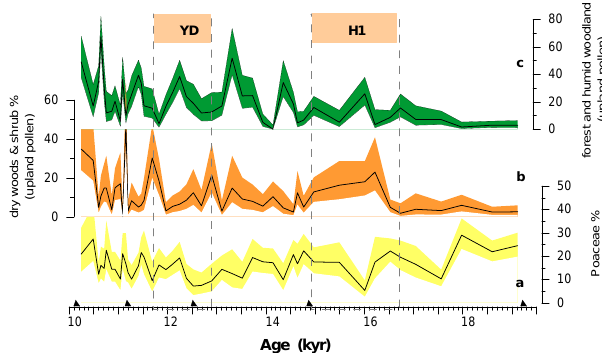
Figure 8. Palynological data showing relative abundances of (a) grass-pollen percentages, (b) pollen percentages of dry woods and shrubs, and (c) pollen percentages of forest and humid wood- lands based on the sum of pollen and spores excluding Cyperaceae, Amaranthaceae, mangrove and Typha (aquatic pollen). Shadings in- dicate the 95% confidence interval. Dashed lines denote time inter- vals of Heinrich event 1 (H1) and the Younger Dryas (YD). Trian- gles indicate age control